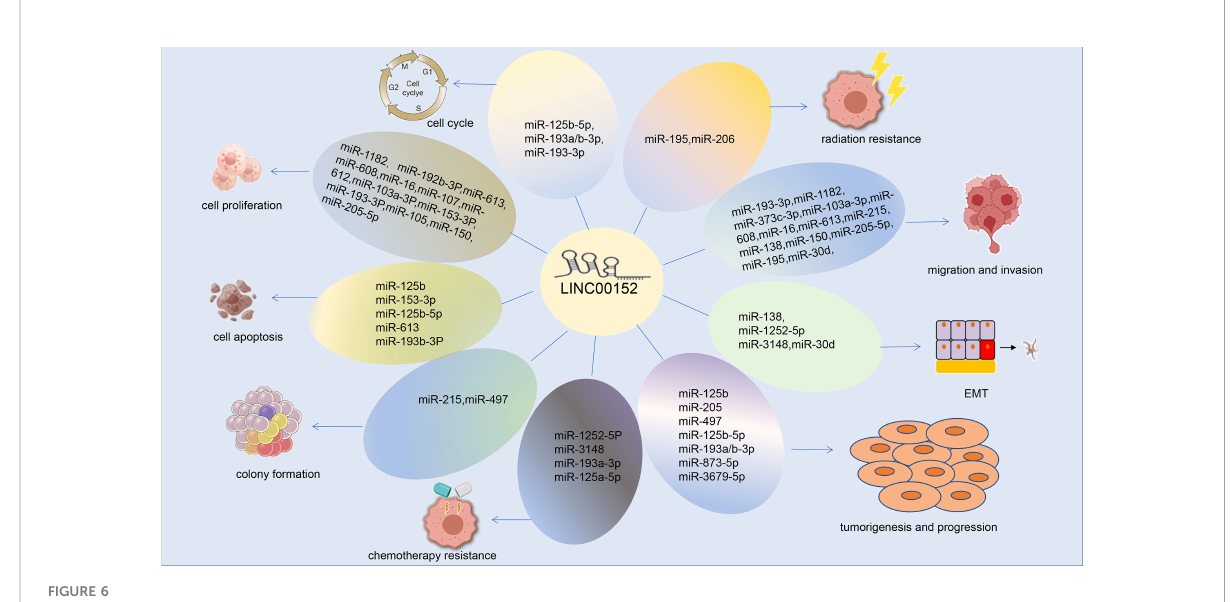
FIGURE 6 LINC00152 and miRNA-related regulatory